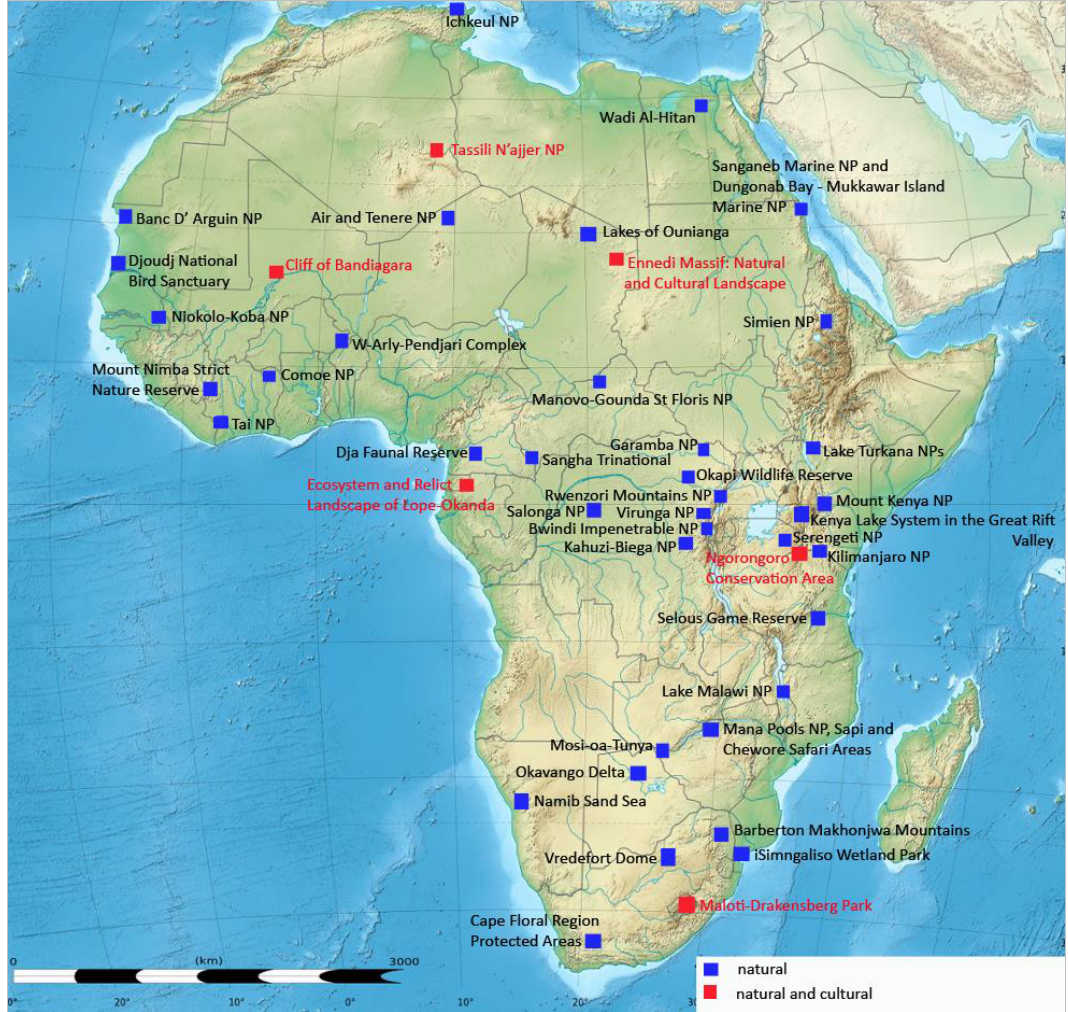
Fig. 1. Natural and mixed (cultural and natural) World Heritage sites in Africa (abbreviation NP – National